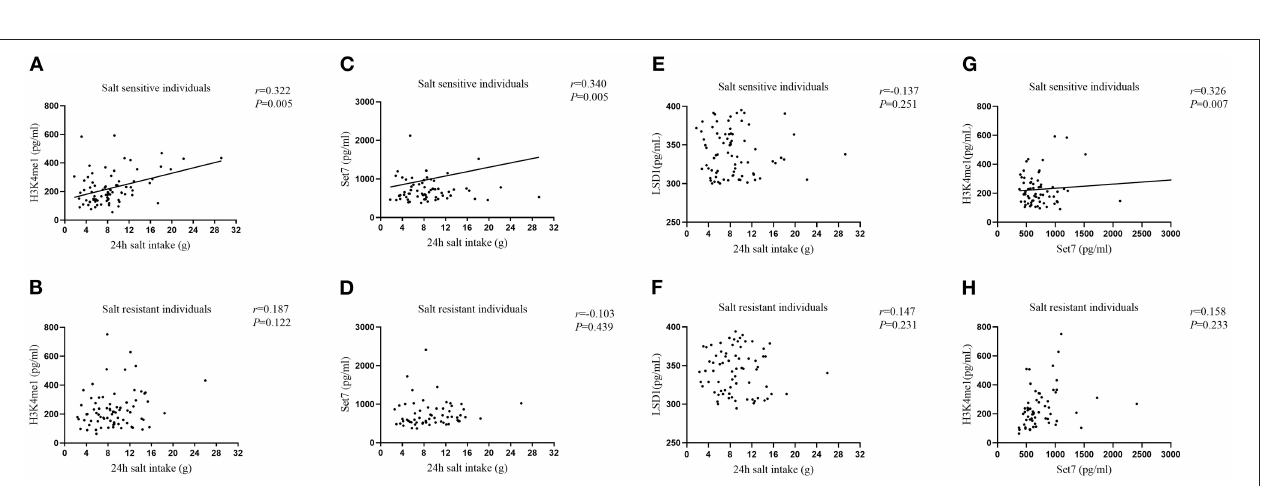
FIGURE 2 | Effects of high salt diet on serum H3K4me1 (A) , Set7 (B) , and LSD-1 (C) in SS and SR participants. SS, salt sensitive participants; SR, salt resistant participants; NS, normal salt group; HS, high salt group. * P < 0.05, high salt group vs. normal salt group.